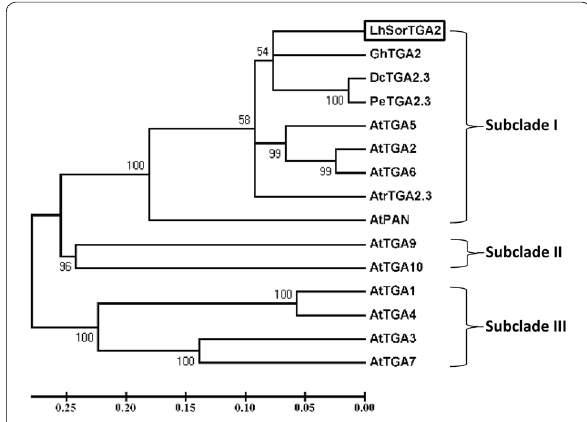
Fig. 2 Phylogenetic relationship of LhSorTGA2 with TGA family proteins from other plants. The phylogram was constructed using the neighbor-joining method in Mega 5, and tested with 1000 bootstrap iterations. The Accession Numbers of all the TGA proteins used for